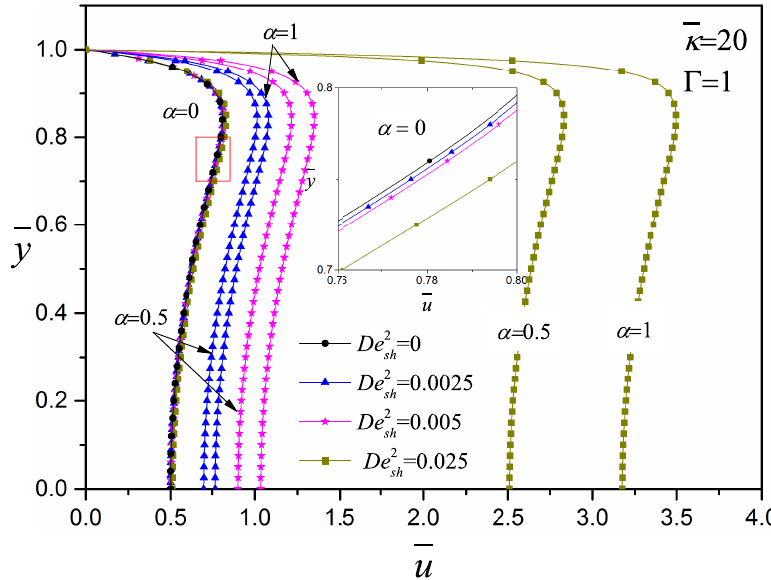
Figure 7. Influence of the viscoelasticity on the velocity profile with κ = 20 and Γ = 1, for the codeformational ( α = 0 ) , mixture ( α = 0.5 ) and corotational ( α = 1 )